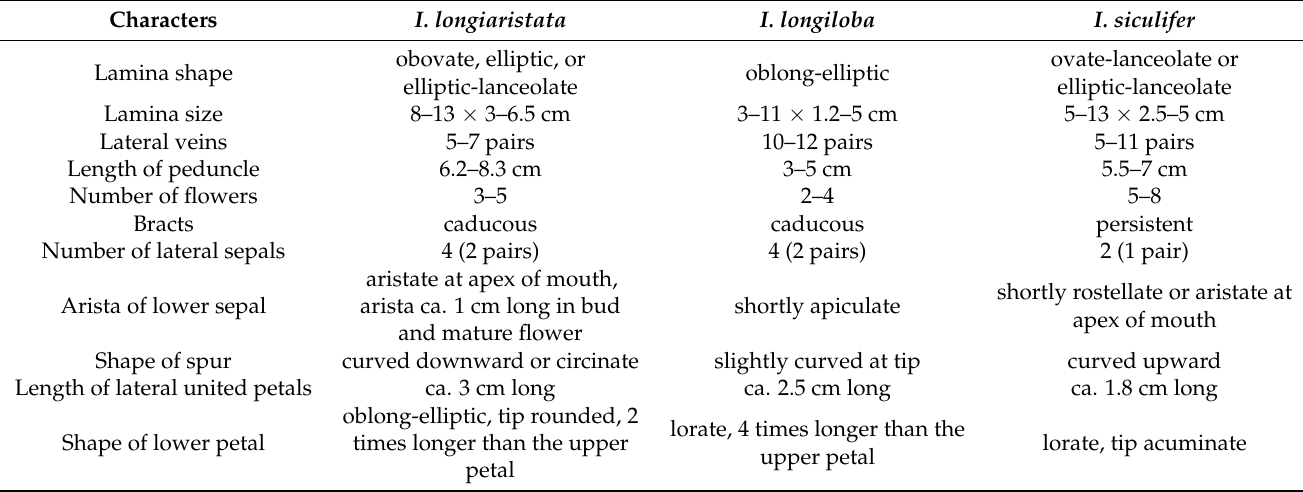
Table 1. Morphological comparisons of Impatiens longiaristata , I. longiloba , and I. siculifer